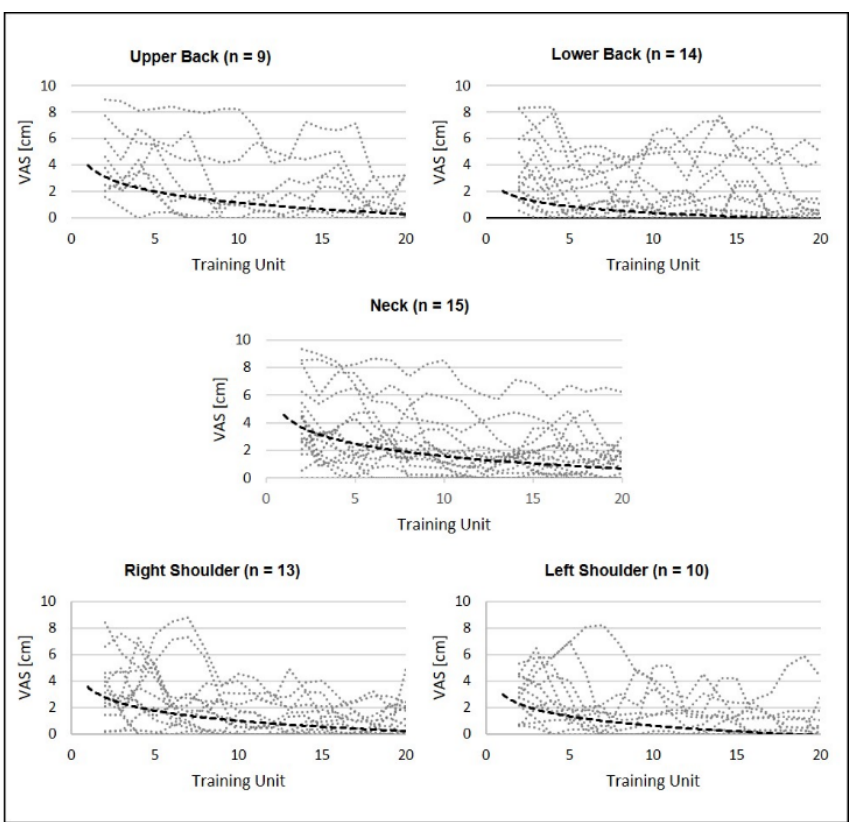
Figure 3. Exponential median and moving average over 20 training units for the upper back, lower back, neck and right and left shoulders. The dotted line indicates pain values for each subject. The respective sample size is indicated at each subfigure.